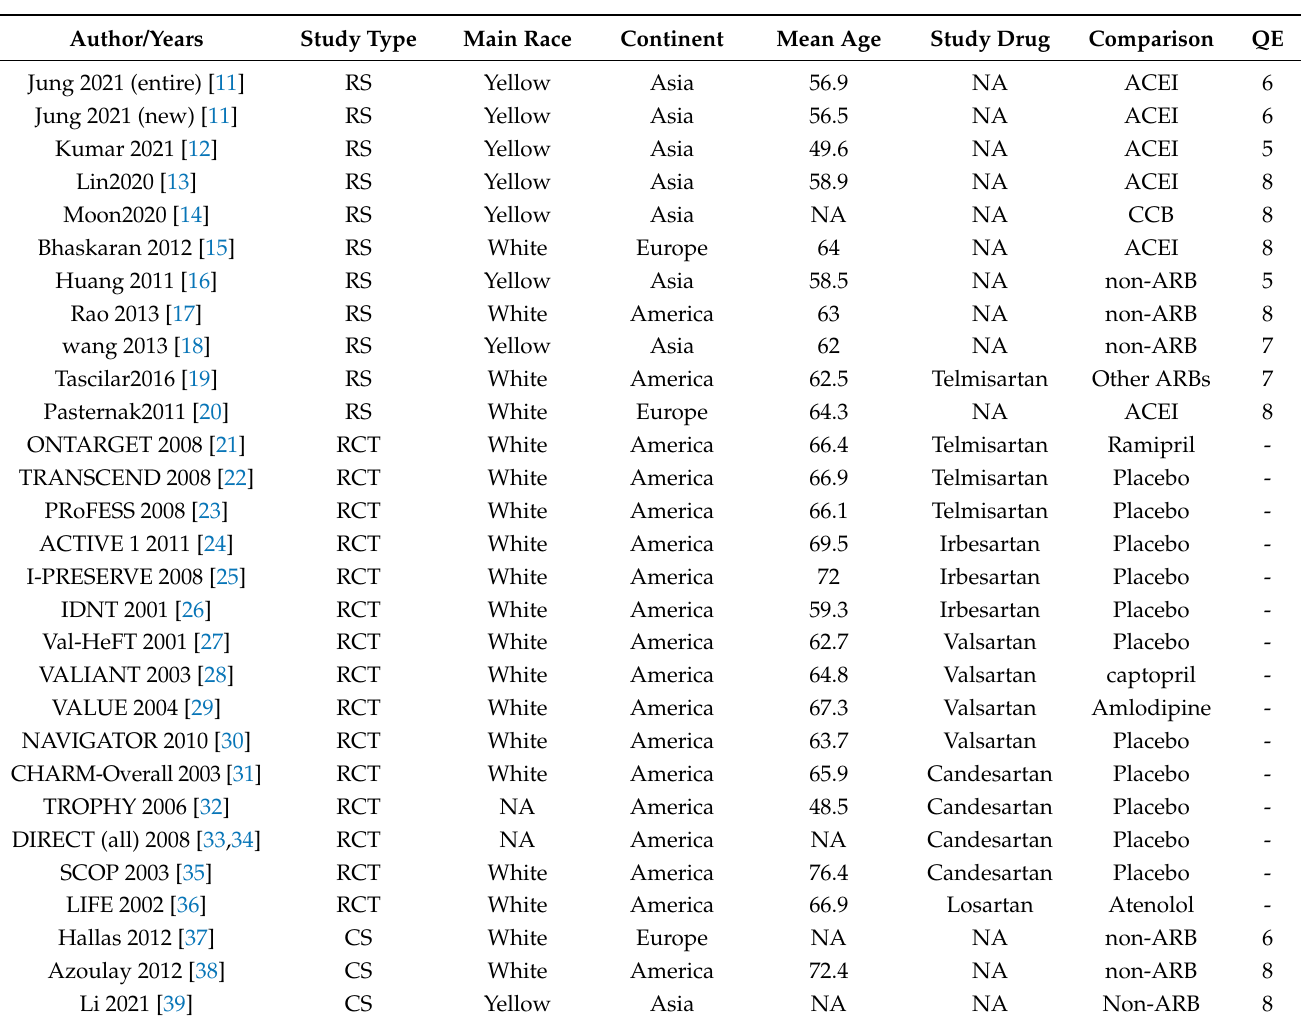
Table 1. The characteristics of the included studies.